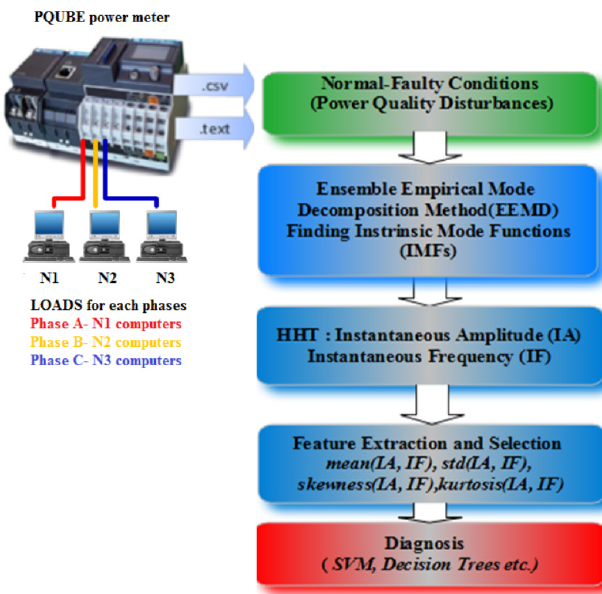
Fig. 13. Schematic model of identification of PQ